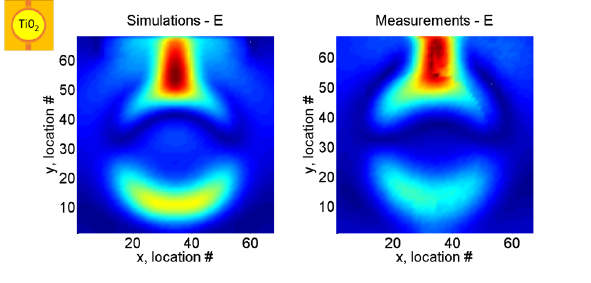
Figure 11: | E z | magnitude of the E-field for simulations (CST (cid:114) , left) and measurements (right) in the vicinity of the ring resonator covered by TiO 2 at f = 2 . 66 GHz.